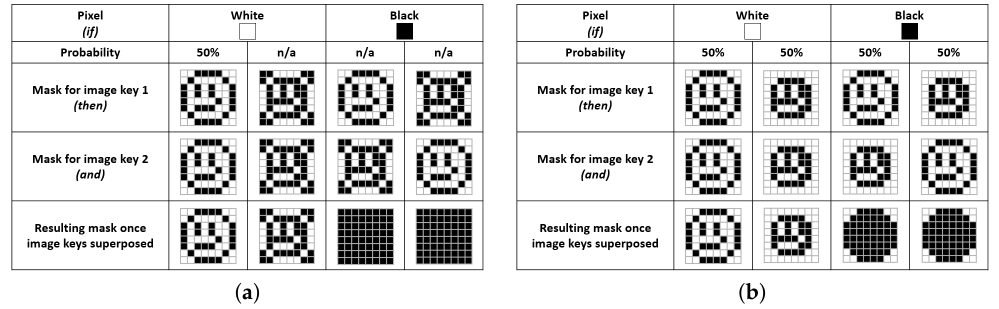
Figure 9. Principle of pictogram-based VC exploiting stylized masks (e.g., with emoticons like smileys [18]). Superposed masks produce a partially complementary mask (see the bottom right mask of ( b )). ( a ) Designed positive mask and generated negative mask; ( b ) with adjusted negative